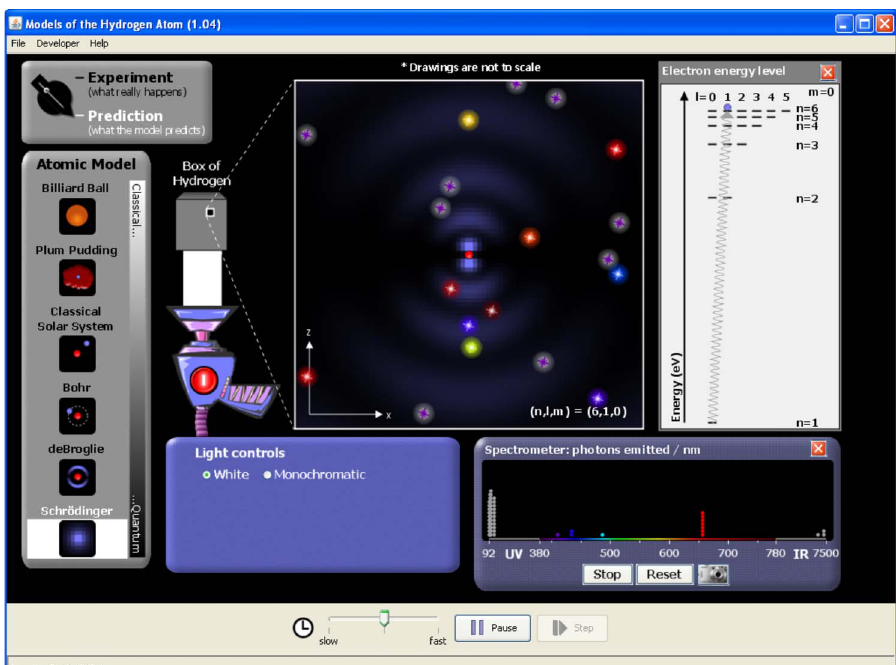
FIG. 10. (cid:1) Color (cid:2) Models of the Hydrogen Atom